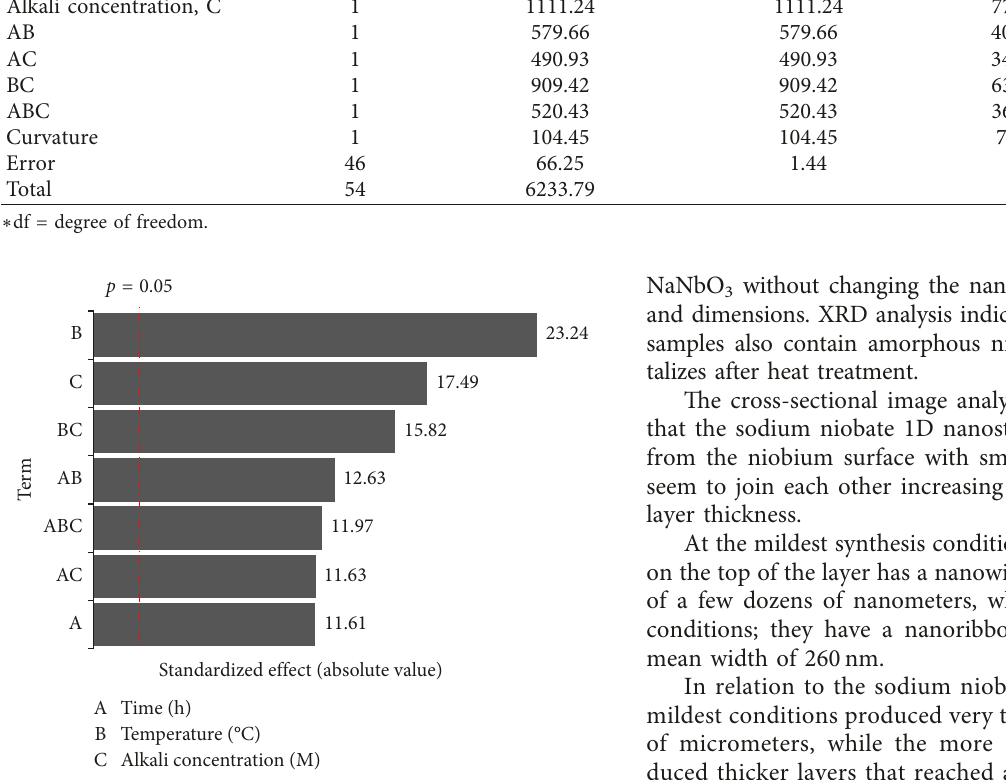
Figure 9: Graph of Pareto showing the variables’ effects on the thickness of the sodium niobate layer based on the experimental